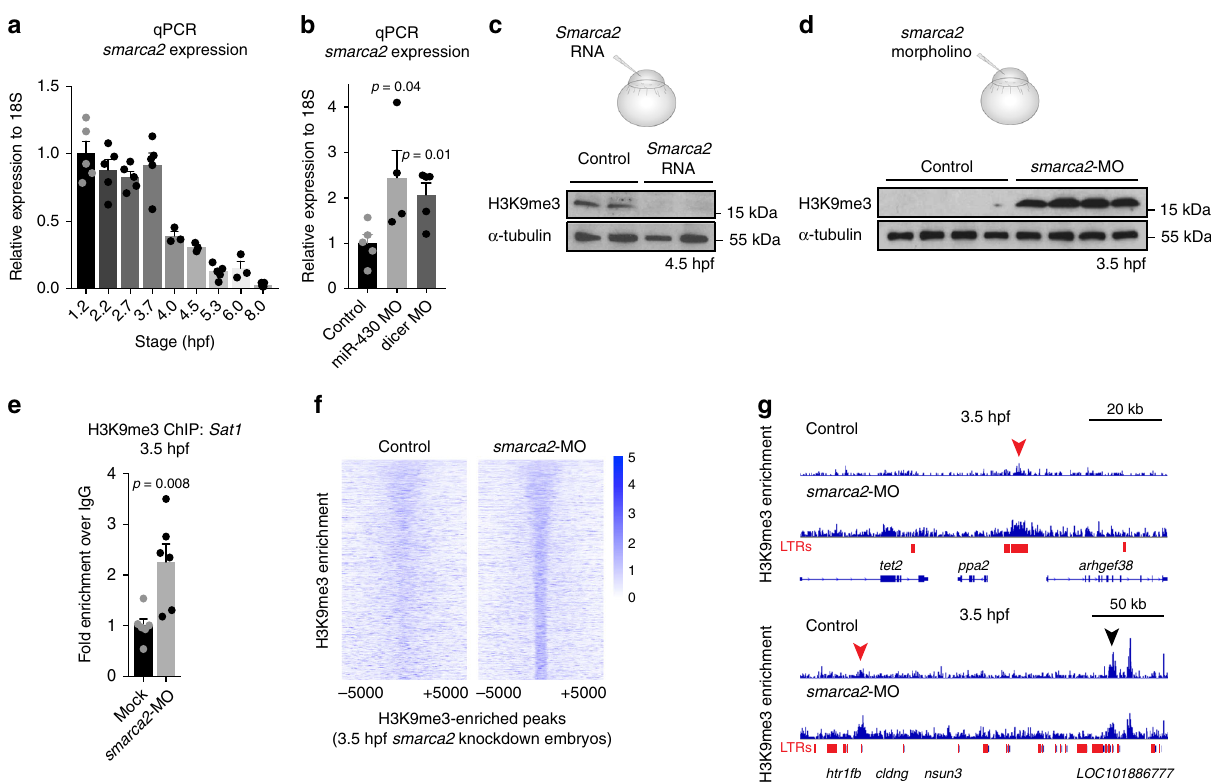
Fig. 5 Smarca2 degradation is required for H3K9me3 establishment. a Quantitative reverse transcription-PCR (RT-PCR) showing smarca2 RNA decreases during maternal to zygotic transition (MZT). Error bars indicate SEM. b Quantitative RT-PCR con fi rming elevated levels of smarca2 transcripts in 5 h post fertilization (hpf) embryos that were injected with 2 ng of miR-430 or dicer morpholino at the one-cell stage. P values were calculated using Student ’ s t test; error bars indicate SEM. c Western blot for H3K9me3 (top) and α -tubulin (bottom) in embryos that were either injected with 200 pg of in vitro transcribed antisense RNA or Smarca2 mRNA at the one-cell stage. Protein was collected for analysis at 4.5 hpf. d Western blot for H3K9me3 (top) and α - tubulin (bottom) in embryos that were either mock injected or injected with 2 ng of smarca2 morpholino at the one-cell stage. Protein was collected for analysis at 3.5 hpf. e Chromatin immunoprecipitation with sequencing (ChIP) for H3K9me3 enrichment at Satellite-1 (Sat1) sequences in embryos injected with a green fl uorescent protein (GFP) control morpholino or with smarca2 morpholino. Analysis was performed at 3.5 hpf. P values were calculated using the Student ’ s t test; error bars indicate SEM. f – g ) ChIP for H3K9me3-enrichment in embryos injected with a scrambled control morpholino or morpholinos targeting smarca2 . f Heatmap depicting H3K9me3 enrichment in control embryos (left) across all H3K9me3 peak centers (±5000 bp) identi fi ed in smarca2 morpholino-injected embryos (right). g Screen shots of two representative genomic regions. Red arrows indicate regions that gain H3K9me3 in smarca2 morpholino-injected samples. The black arrow indicates a region that is enriched for H3K9me3 in both control and morpholino-injected embryos. Source data for panels c and d is provided as a source data fi